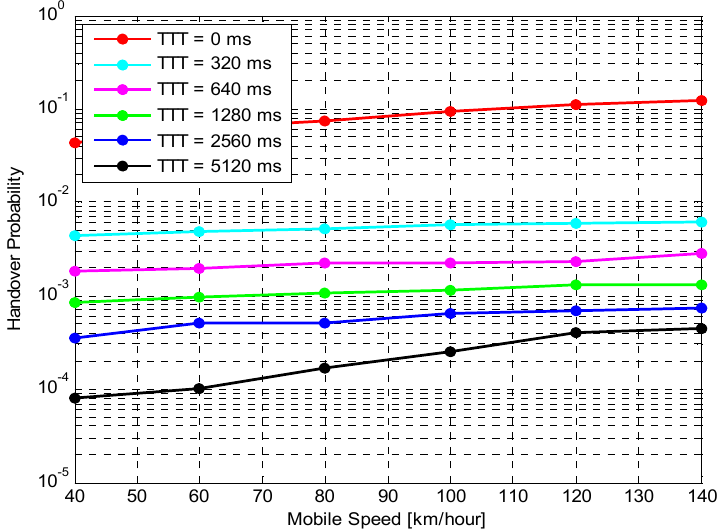
Figure 7. Handover probability versus UE speeds.